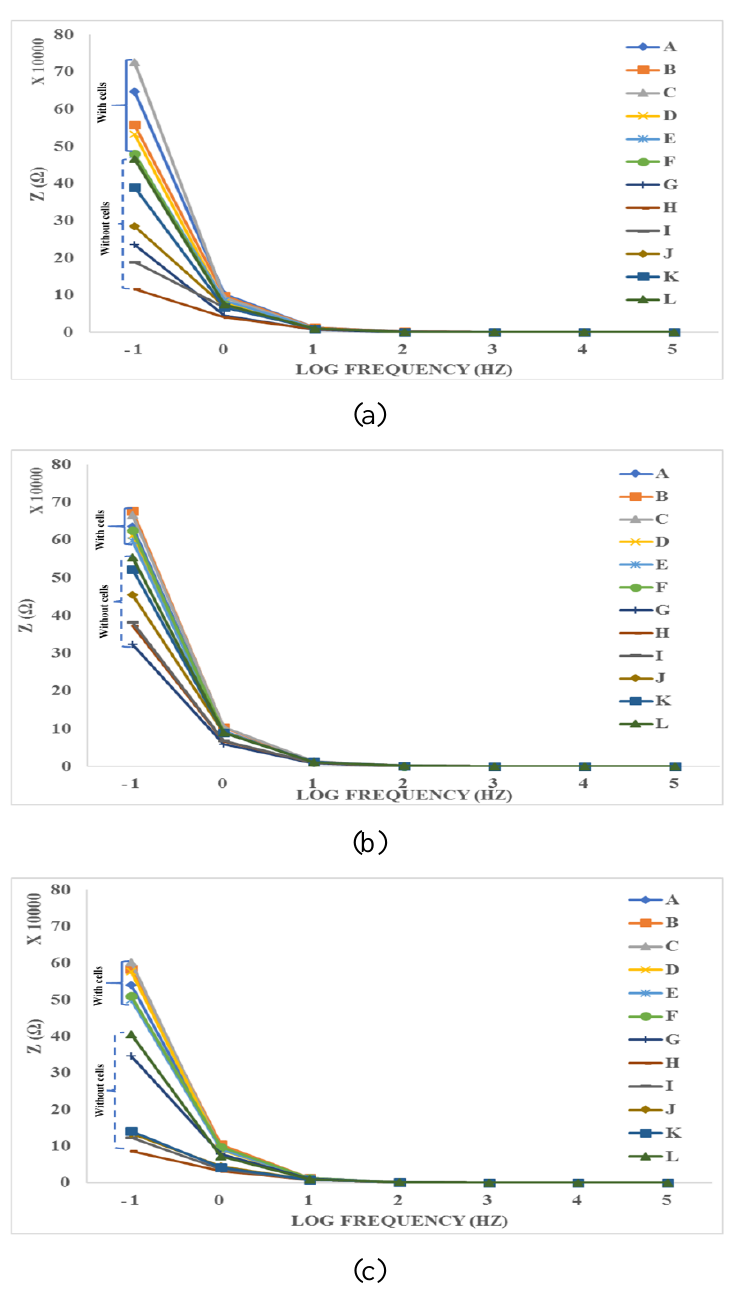
Figure 10. Impedance Spectroscopy Readings of the control and di ff erent concentrations of N2a-SPIONs using a range of frequency from the log − 1 to 5 (0.1 to 100000Hz). A 2.5 × 10 5 cells / mL concentration was used for the three groups(( a ) group 1, ( b ) group 2 and ( c ) group 3). Legend shows the di ff erent concentrations of SPIONs and the control groups where A = N2a (control), B = 25 µ g / mL with cells, C = 50 µ g / mL with cells, D = 100 µ g / mL with cells, E = 200 µ g / mL cells, F = 300 µ g / mL with cells, G = CCM (Control), and H = 25 µ g / mL without cells, I = 50 µ g / mL without cells, J = 100 µ g / mL without cells, K = 200 µ g / mL without cells and L = 300 µ g / mL without cells.